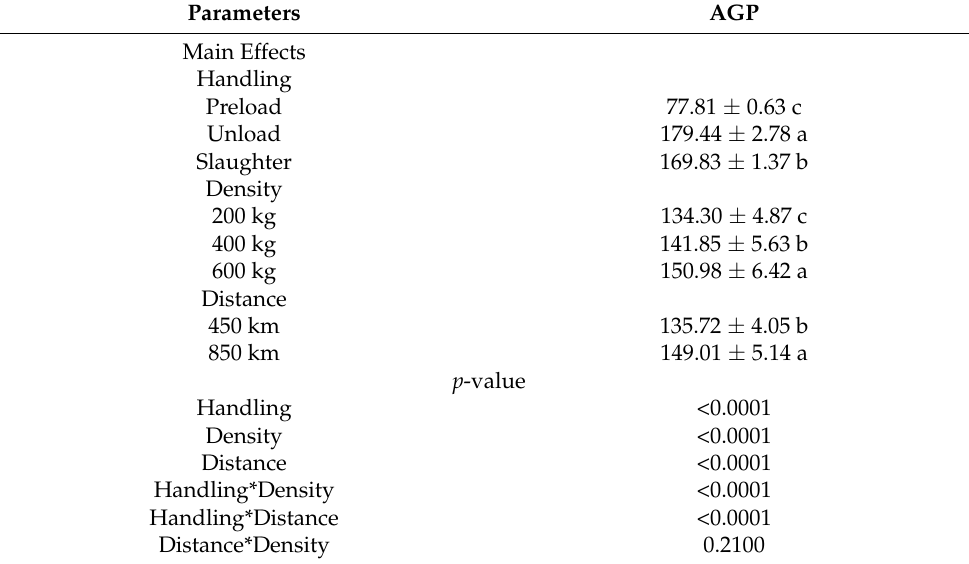
Table 5. Serum α -1 glycoprotein (AGP) as affected by handling, stocking density, and distance in road transported cattle.